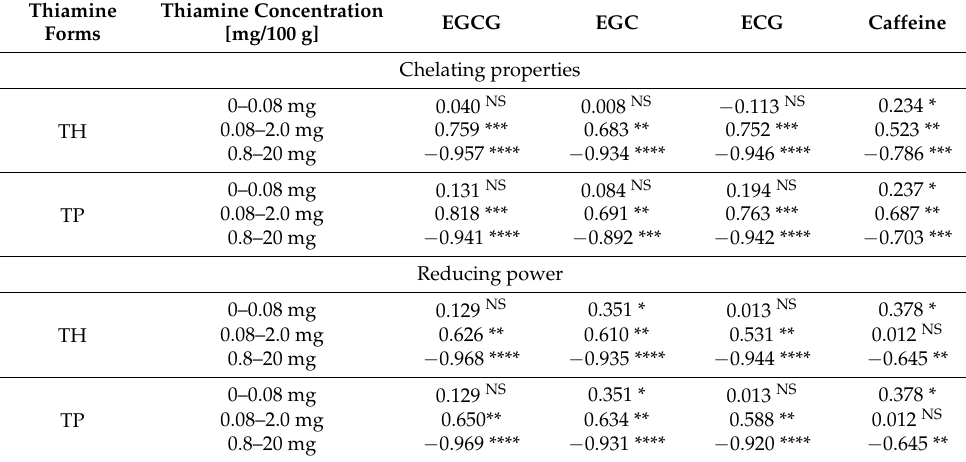
Figure 4. The ABTS scavenging capacity of EGCG ( a ), EGC ( b ), ECG ( c ) and caffeine ( d ) in the presence of TH ( 1 ) and TP ( 2 ), compared to a sample without thiamine; different letters (lower letters in the same concentration of antioxidant; bold letters in the same concentration of thiamine denote a significant difference at p < 0.05 (one-way ANOVA, and post hoc Tukey test). Table 1. Correlation coefficients between the chelating activity, reducing power and the free radicals scavenging indices of flavonoids and caffeine in the presence of TH or TP.